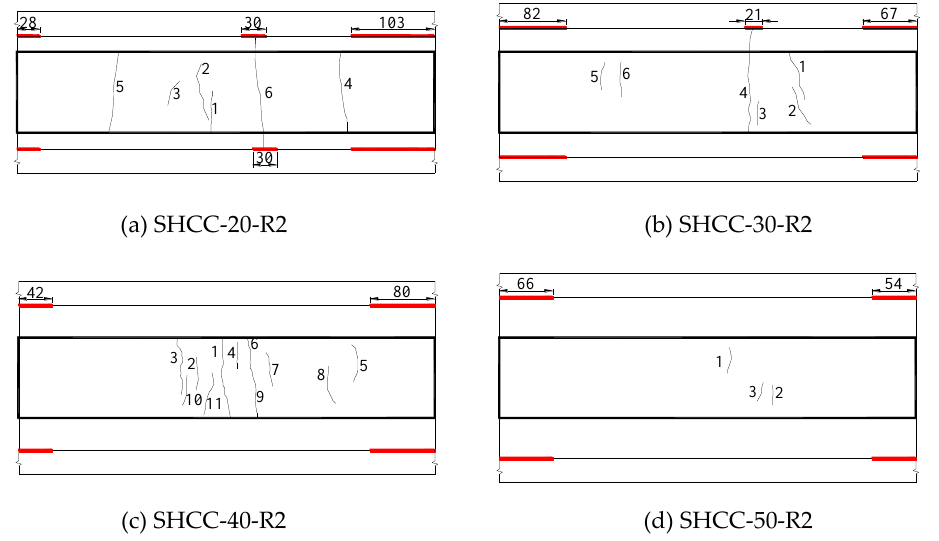
Figure 13. Influence of repair layer thickness on cracking and interfacial delamination patterns of the repaired beams (mm).